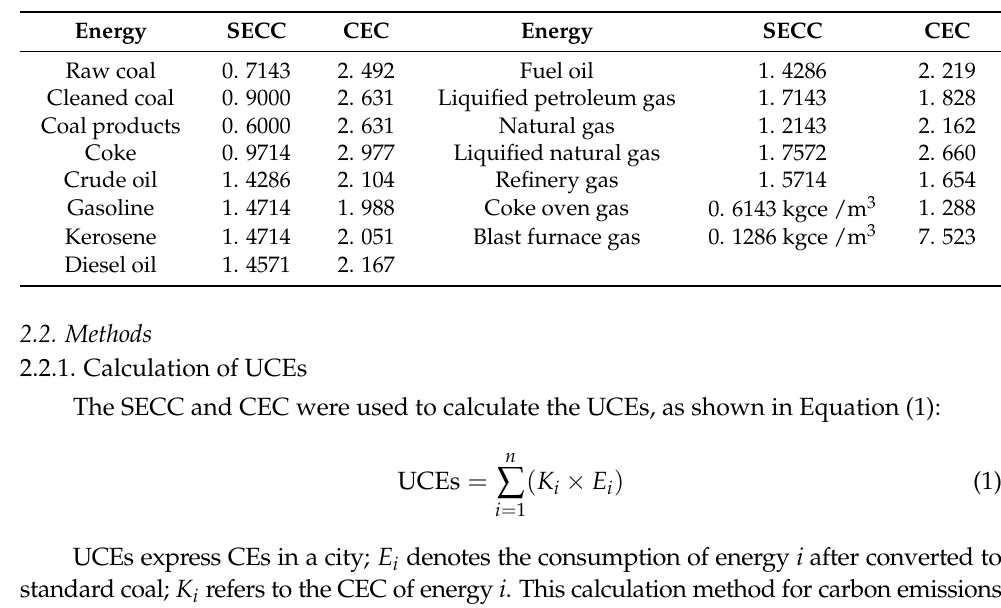
Table 1. The SECC and CEC of different energy